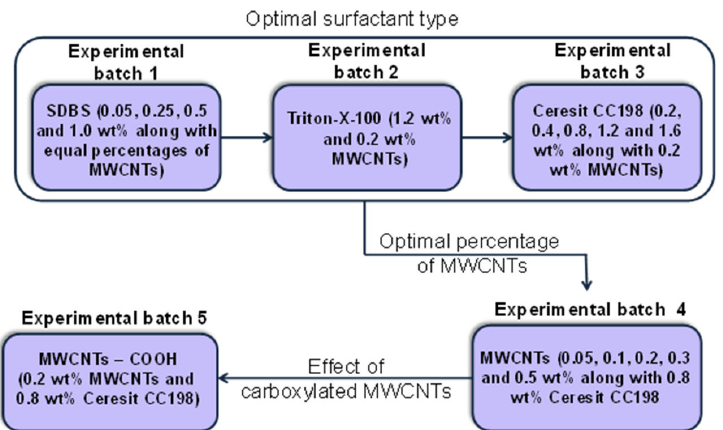
Figure 2. Experimental batches investigated in the present study (the percentages shown are by weight (wt%) of